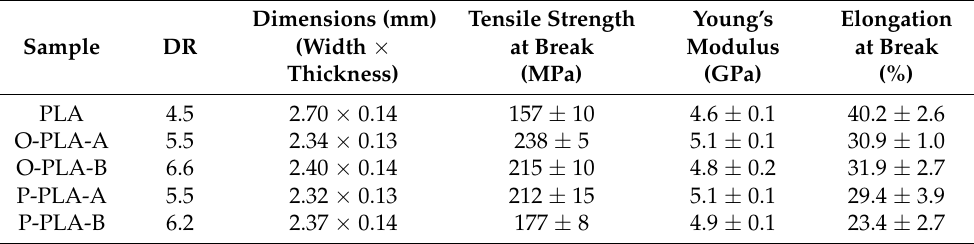
Table 8. Mechanical properties (Young’s modulus, tensile strength, and elongation at break), draw ratio (DR), and dimensions of neat and functionalized PLA flat tape samples. Dimensions Sample DR